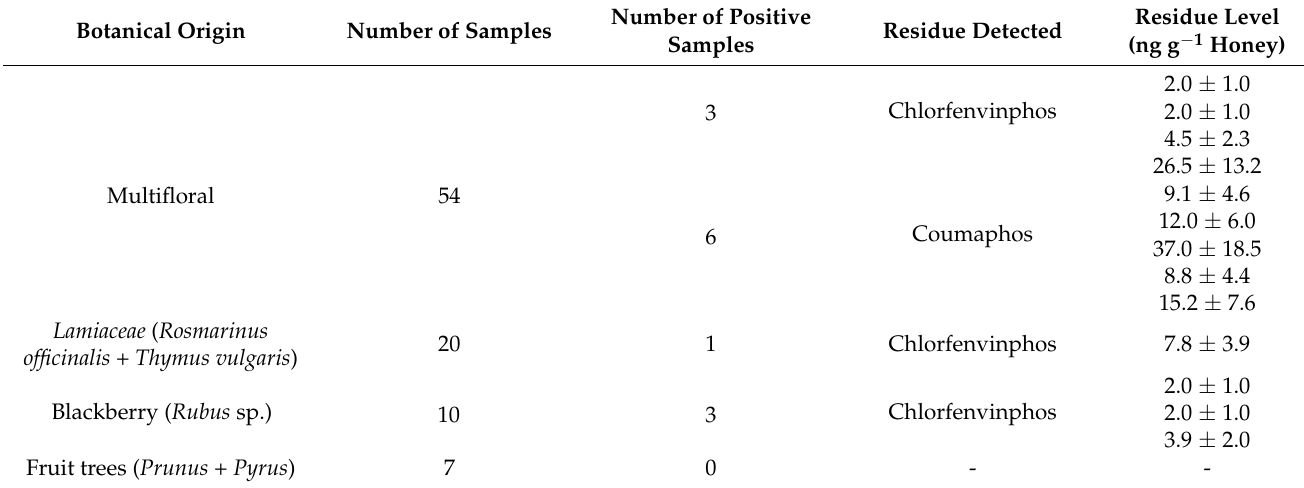
Table 1. Pesticide residues in raw honey samples according to their botanical